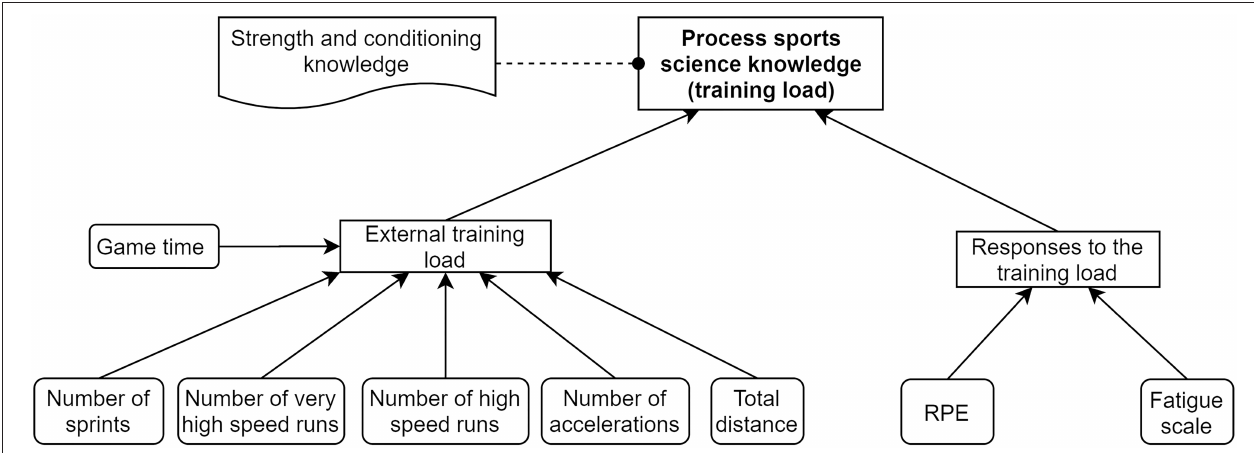
FIGURE 6 | The decision requirement diagram (DMN) of the process sports science knowledge decision point within the As-Is state of daily training load management (M2) process model depicted in Figure 5 . Note that the data inputs (except game time) contributing to the external training load decision were generated from micro-technology (GPS).